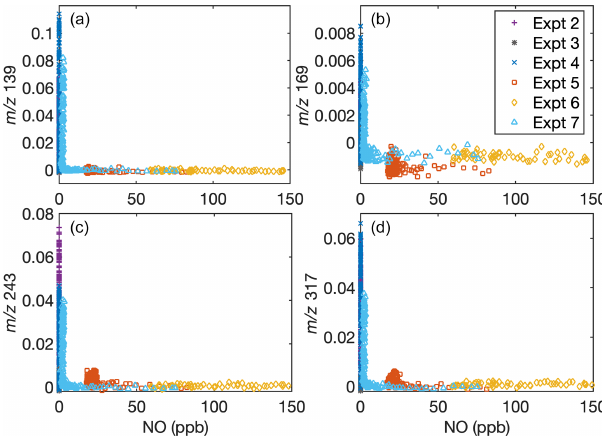
Figure A1. Dependence of gas-phase D5 oxidation products on the NO concentration in the chamber indicates that oxidation chem- istry changes depending on NO concentrations. Signals normalized to the reagent concentrations with (a) m/z = 139, (b) m/z = 169, (c) m/z = 243, and (d) m/z = 317 are shown as a function of NO concentration. Experiment C6 has [NO] extending to > 450ppb, but since the normalized signal remains close to 0, data above [NO] = 150ppb are cut off for clarity. Because of the inaccuracy of NO measurements during oxidation when methyl nitrite is present, C8 is not included.